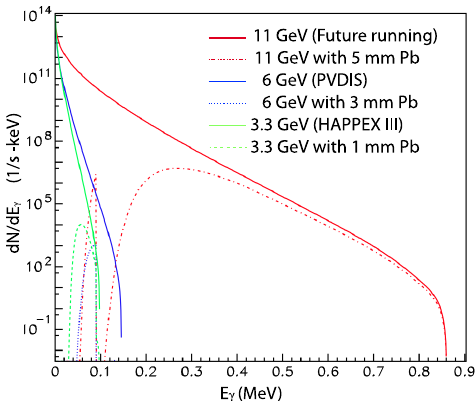
FIG. 2. Comparison of the synchrotron radiation from a 100 μ A electron beam produced within the acceptance of the Compton polarimeter's photon detector, for two completed experiments, PVDIS at 6 GeV and HAPPEX III at 3.3 GeV with the repositioned 11 GeV Compton system. The dashed/ dotted lines show the effect of thin lead